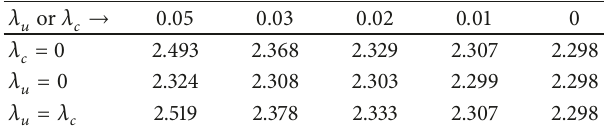
Table 2: The cross section (in pb) for the process 𝑒 − 𝑝 → 𝑒 − 𝑊 ± 𝑞+𝑋 dependingontheFCNCcouplings 𝜆 𝑢 and 𝜆 𝑐 .Thevaluescorrespond to the case that only one of the couplings is allowed to change at a time.